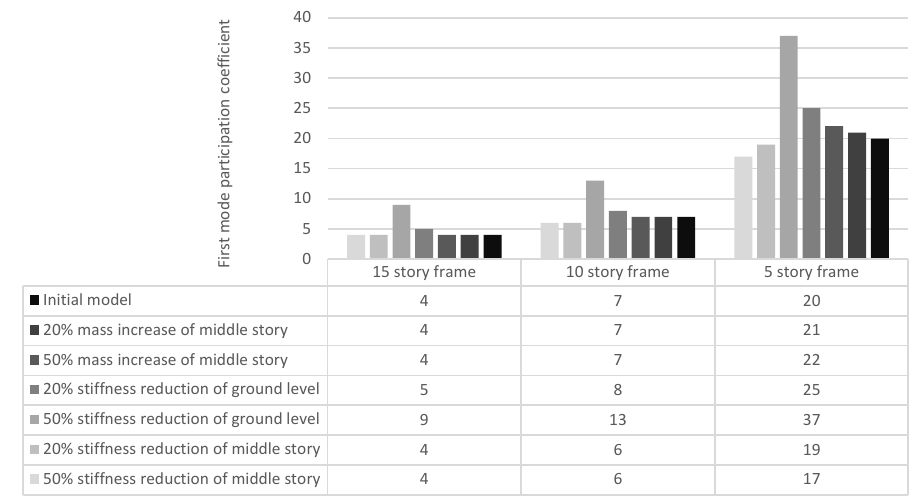
Fig. 9. First mode participation coefficient of structure.